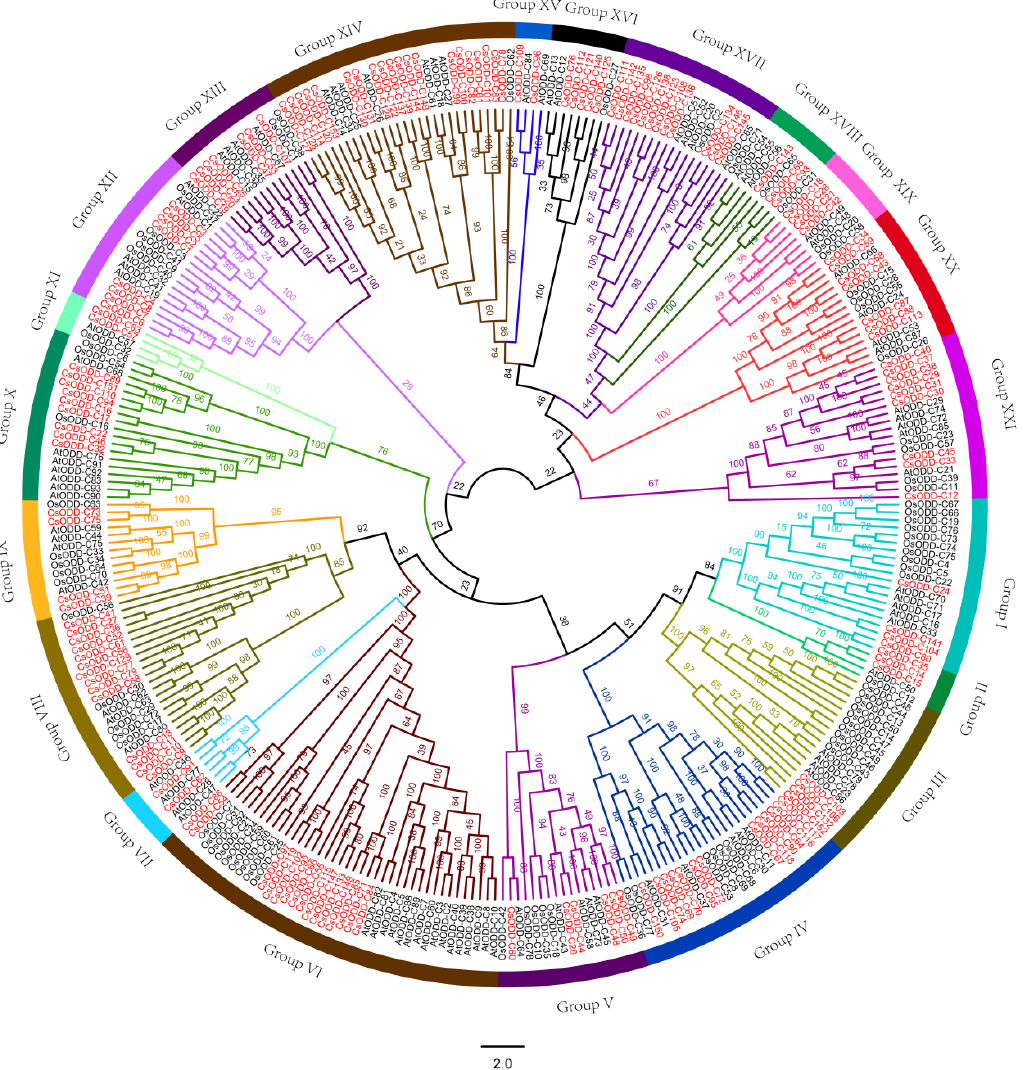
Figure 2. Phylogenetic analysis of 2ODD−C gene family in C. sinensis , O. sativa , and Arabidopsis . An unrooted phylogenetic tree of 2ODD−C gene family among C. sinensis , O. sativa , and Arabidopsis was constructed using the maximum-likelihood method in PhyML 3.0 software, with a bootstrap test (replicated 100 times). The 2ODD−C gene families in C. sinensis , O. sativa , and Arabidopsis are marked red, black, and black, respectively. The values of the bootstrap are shown on the nodes. Different color arcs indicate different groups of ODD−Cs.